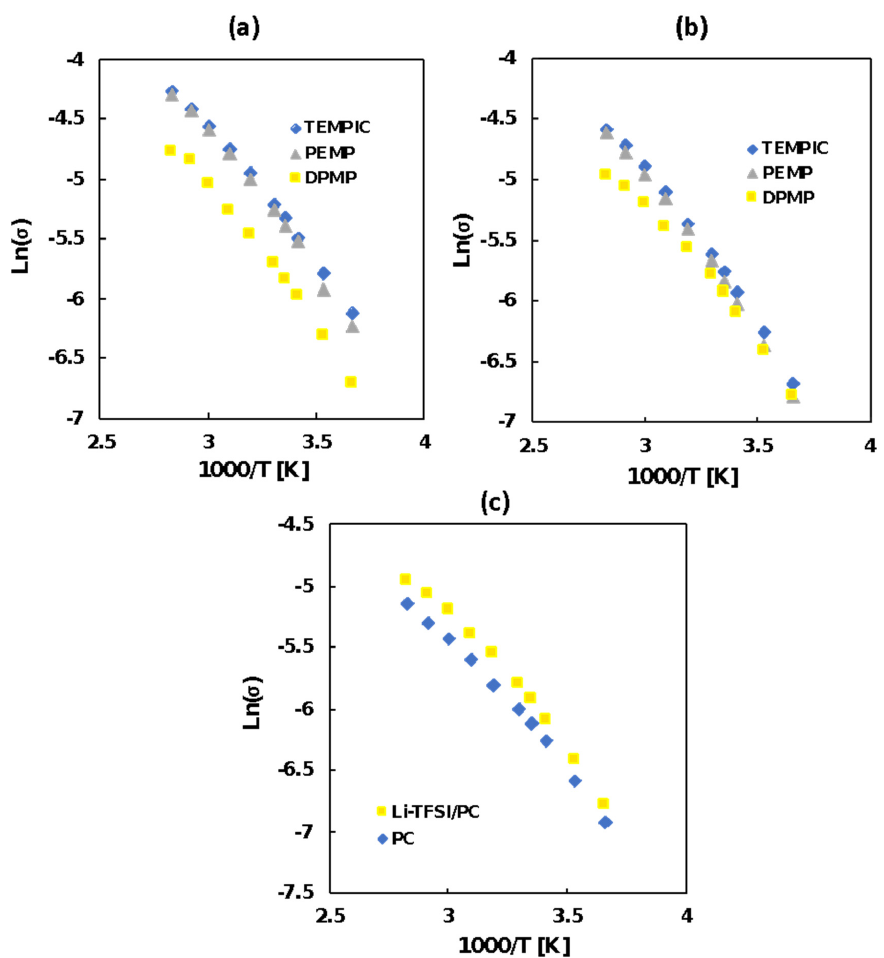
Figure 5. Arrhenius plots of ( a ) 20 wt % and ( b ) 30 wt % monomer-containing DPMP-DAIM TFSI, PEMP-DAIM TFSI, TEMPIC-DAIM TFSI ionic gels in Li-TFSI/PC (1 M) and ( c ) Arrhenius plots of 30 wt % monomer-containing DPMP-DAIM TFSI ionic gels in Li-TFSI / PC (1 M) and Table 3. Vogel–Tammann–Fulcher (VTF) equation parameters and apparent lithium ion diffusion coefficients (Dapp) for ionic gels.